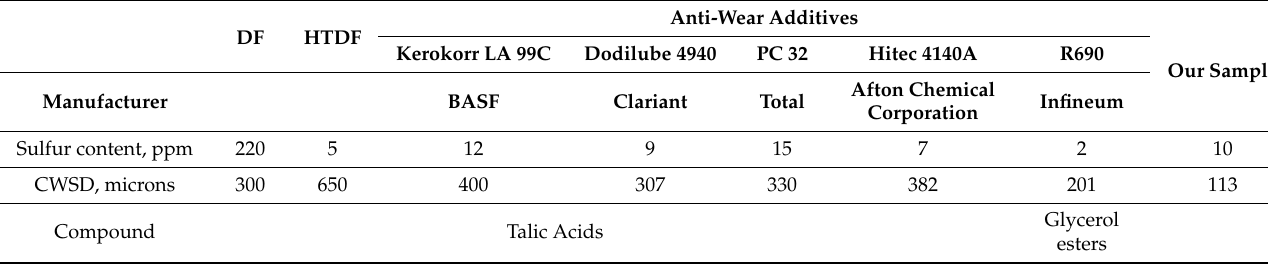
Table 2. Anti-wear additives